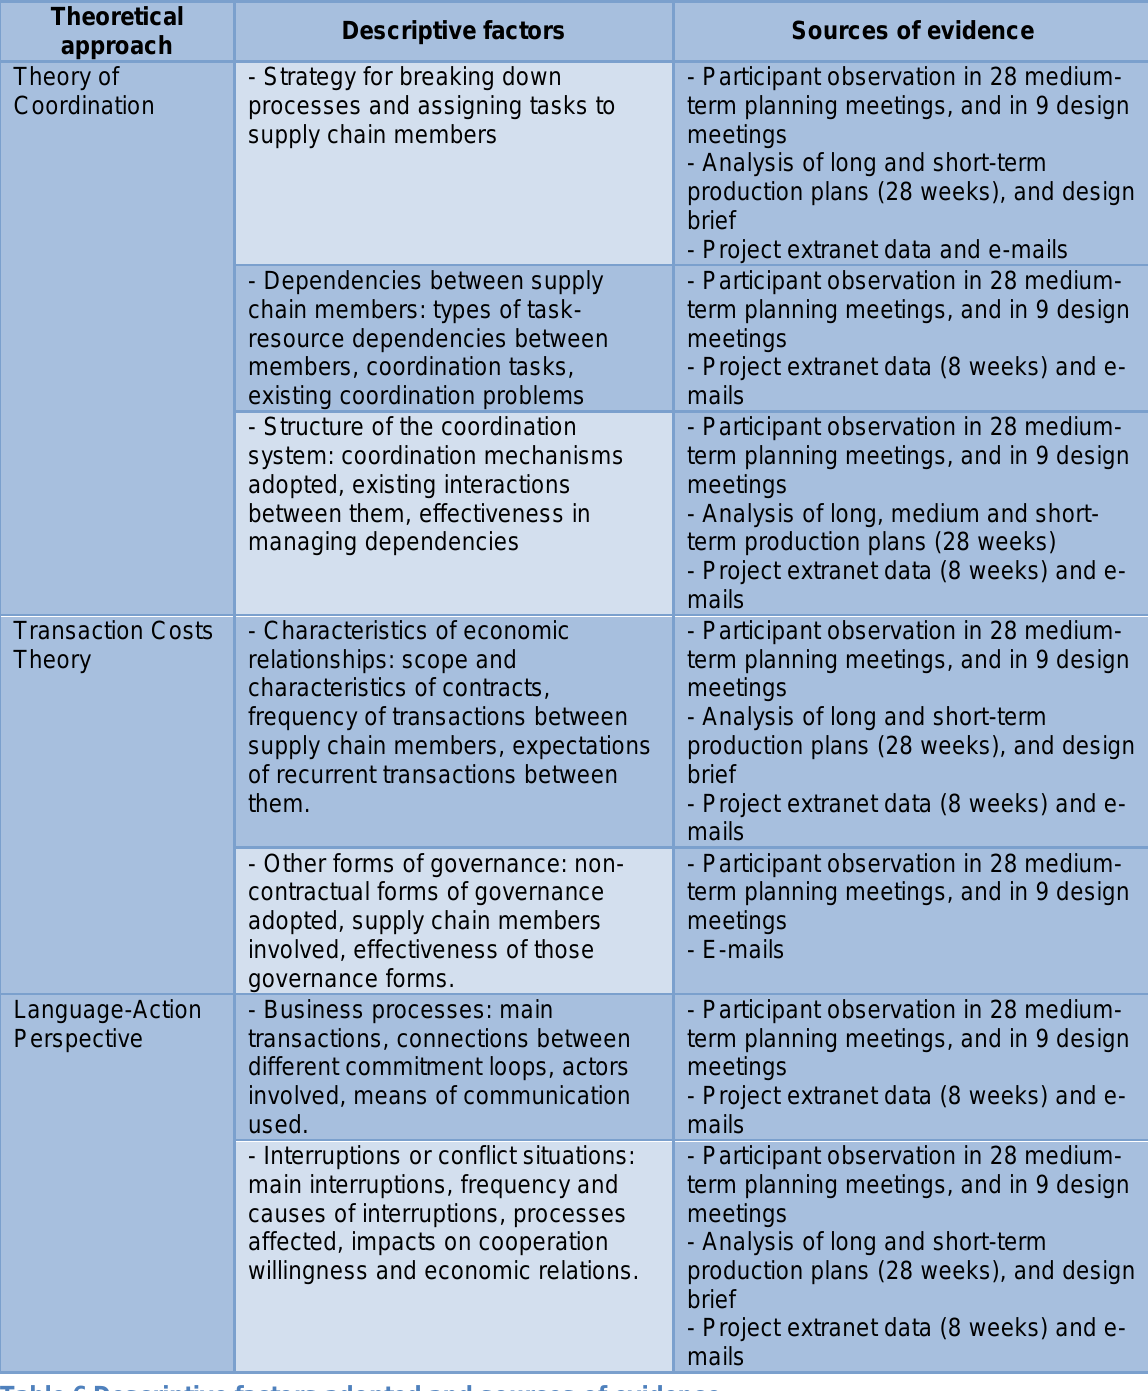
construction project supply chains’ , Australasian Journal of Construction Economics and Building, 11 (3) 1-17